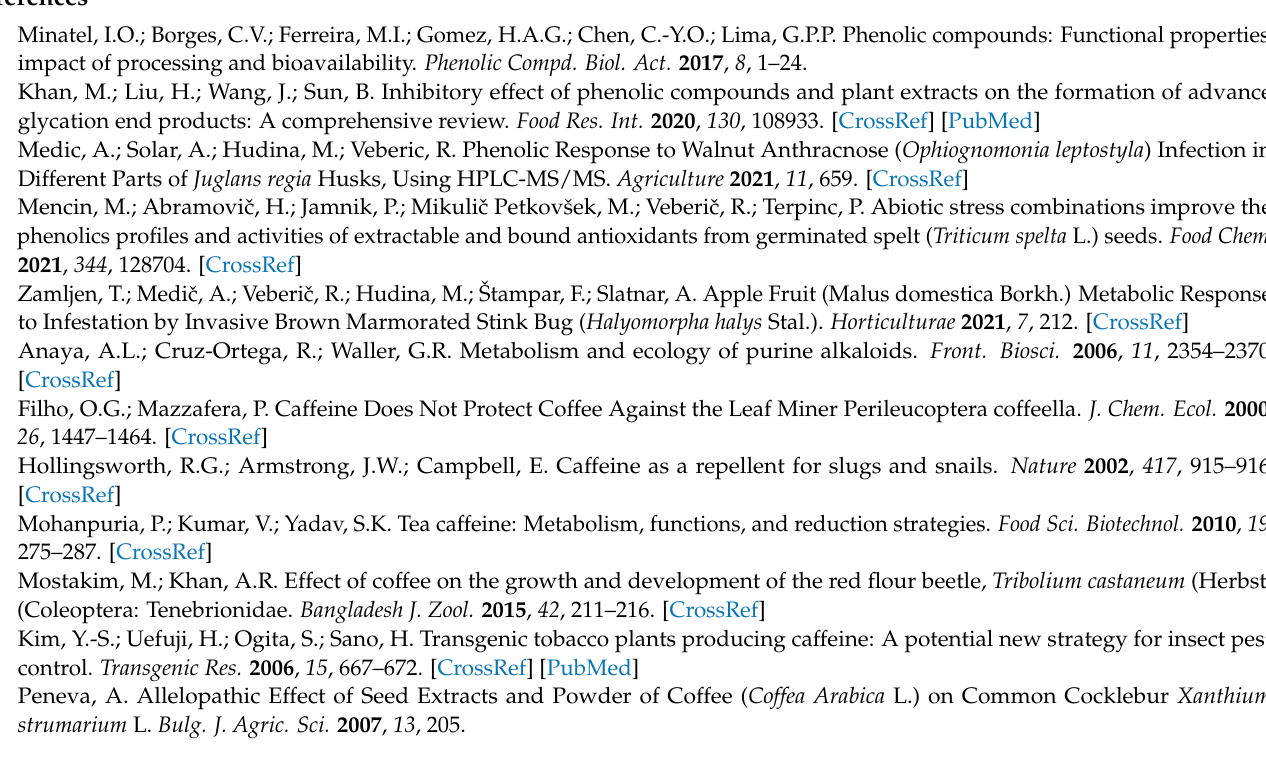
Supplementary Materials: The following are available online at https://www.mdpi.com/article/ 10.3390/horticulturae7110443/s1, Table S1: Caffeine content (mean ± SE, in mg/g) and decrease (%) in coffees and teas during successive extractions with different solvents (W: water; M: methanol; W:M water: methanol mix). Different letters indicate statistical significance ( p ≤ 0.05) in caffeine content between solvents. Table S2: Phenolic compounds content (mean ± SE, in mg/kg) and decrease (%) in green tea during successive extractions with different solvents (W: water, M: methanol; W:M water: methanol mix). Different letters indicate statistical significance ( p ≤ 0.05) in phenolic content between solvents. Table S3: Phenolic compounds content (mean ± SE, in mg/kg) and decrease (%) in black tea during successive extractions with different solvents (W: water, M: methanol; W:M water: methanol mix). Different letters indicate statistical significance ( p ≤ 0.05) in phenolic content between solvents. Table S4: Phenolic compounds content (mean ± SE, in mg/kg) and decrease (%) in mate tea during successive extractions with different solvents (W: water, M: methanol; W:M water: methanol mix). Different letters indicate statistical significance ( p ≤ 0.05) in phenolic content between solvents. Table S5: Phenolic acids content (mean ± SE, in mg/kg) and decrease (%) in coffees during successive extractions with different solvents (W: water, M: methanol; W:M water: methanol mix). Different letters indicate statistical significance ( p ≤ 0.05) in phenolic content between